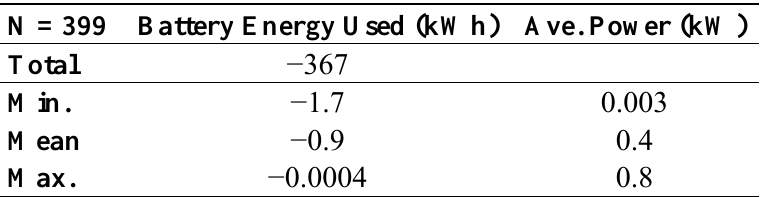
Table 8. Charging energy summary.